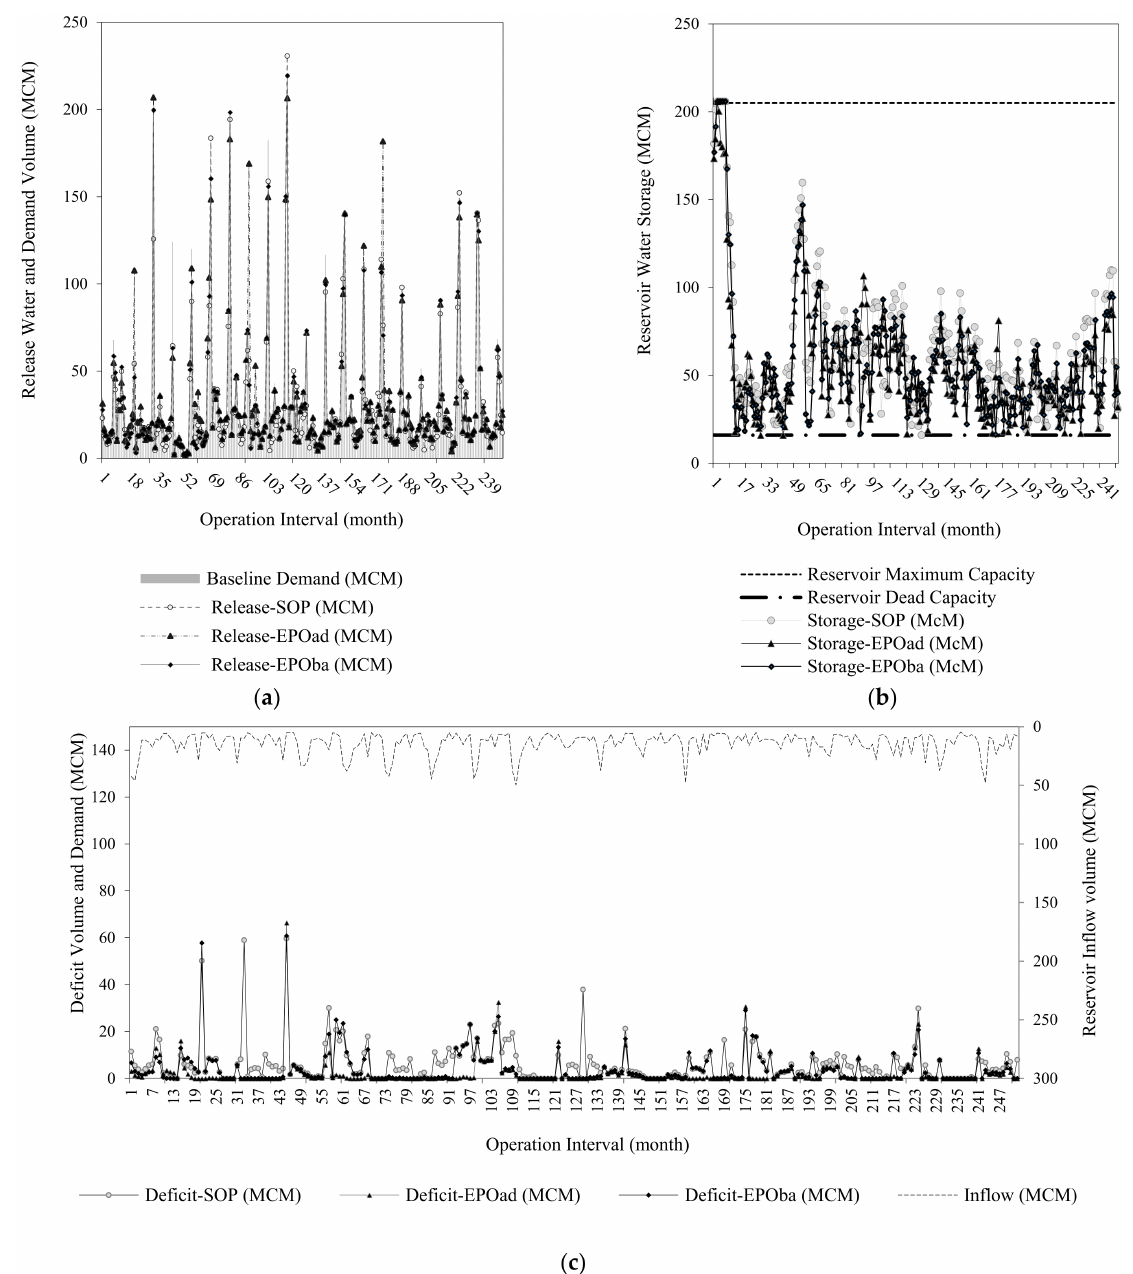
Figure 7. Change in output, storage, deficit volume using EPO ad and EPO ba algorithms in the third and fourth scenarios: ( a ) Released water and demand Volume (MCM); ( b ) Reservoir storage (MCM); ( c ) Deficit, demand and reservoir inflow volumes